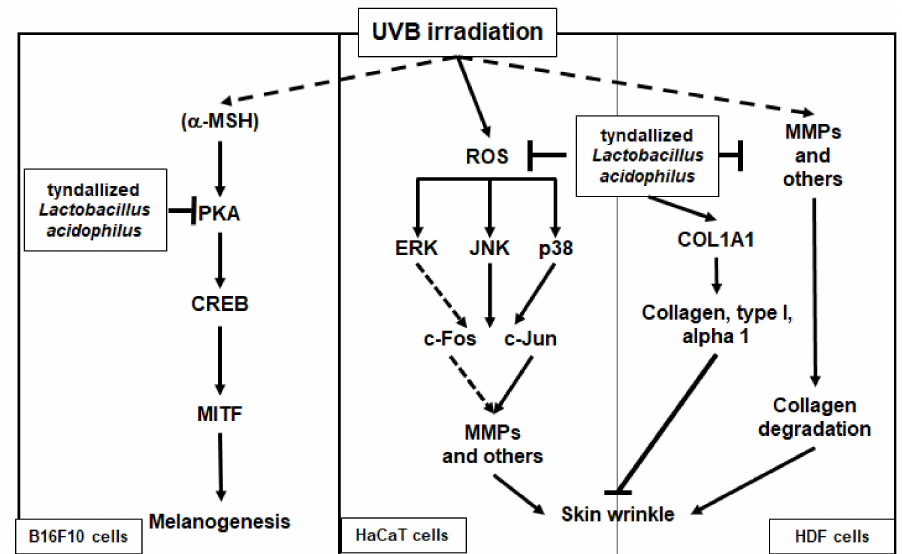
Figure 5. Mechanism of the antiwrinkle and antimelanogenesis effects of tyndallized Lactobacillus acidophilus KCCM12625P. Arrows indicate positive regulation and T- bars indicate negative